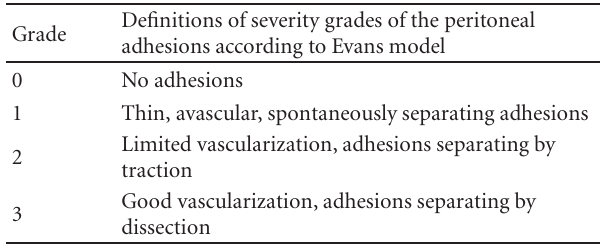
Table 1: Definitions of the grades of peritoneal adhesionsaccording to Evans.